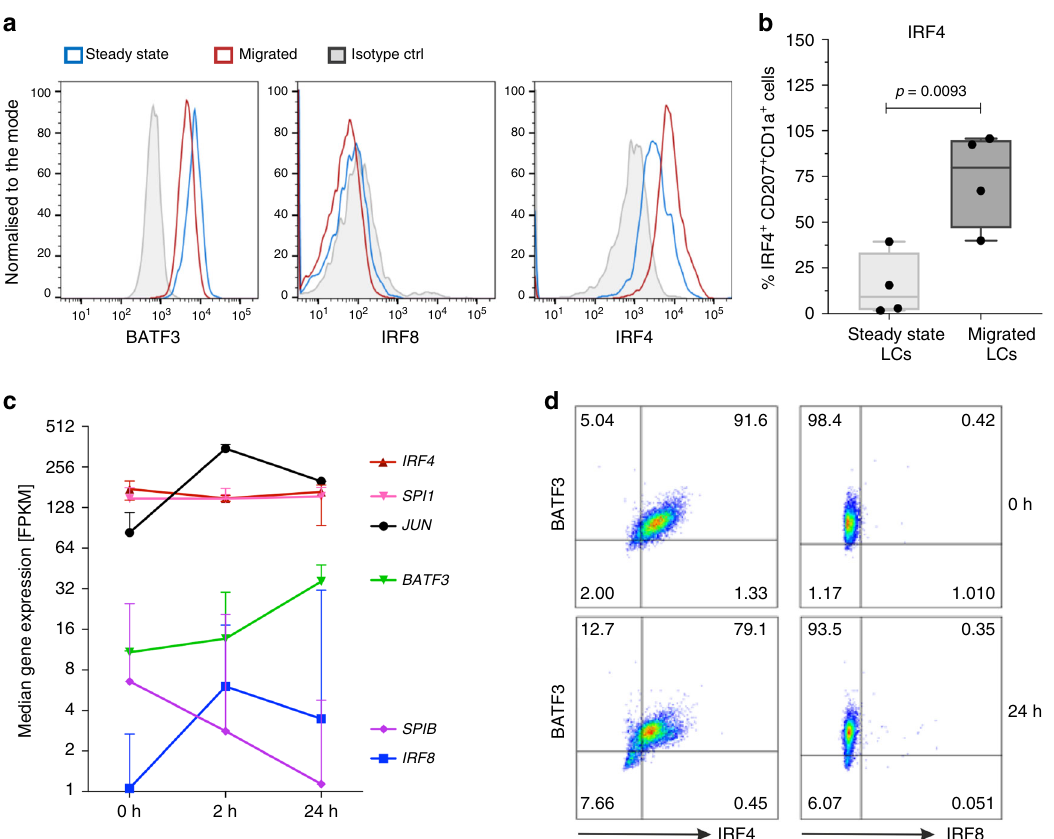
Fig. 5 Human LCs upregulate expression of IRF4 upon migration, but lack IRF8. a IRF4, but not IRF8, protein expression is upregulated in BATF3-positive LC during migration from the epidermis. A representative FACS analysis of 3 – 5 independent donors, gates set using isotype controls for each antibody (nuclear staining for IRF4, IRF8 and BATF3). b IRF4 protein expression in steady-state vs migrated LCs. IRF4 + LCs (%) as measured by fl ow cytometry, median± range, n = 4, three paired samples from independent donors, unpaired t test, box and whiskers show min and max value, line at median. Source data are provided as a Source Data fi le. c Transcript levels of key transcription factors in migrated LCs before and after TNF stimulation (2 h, 24 h). FPKM values, median ± range of three biological donors are shown. Source data are provided as a Source Data fi le. d Expression of IRF4 and BATF3 in response to TNF signalling (24 h). Representative graphs of fi ve independent donors, gates set using isotype controls for each antibody (Nuclear staining for IRF4, IRF8 and